Question: Express in one sentence what the figure is showing.
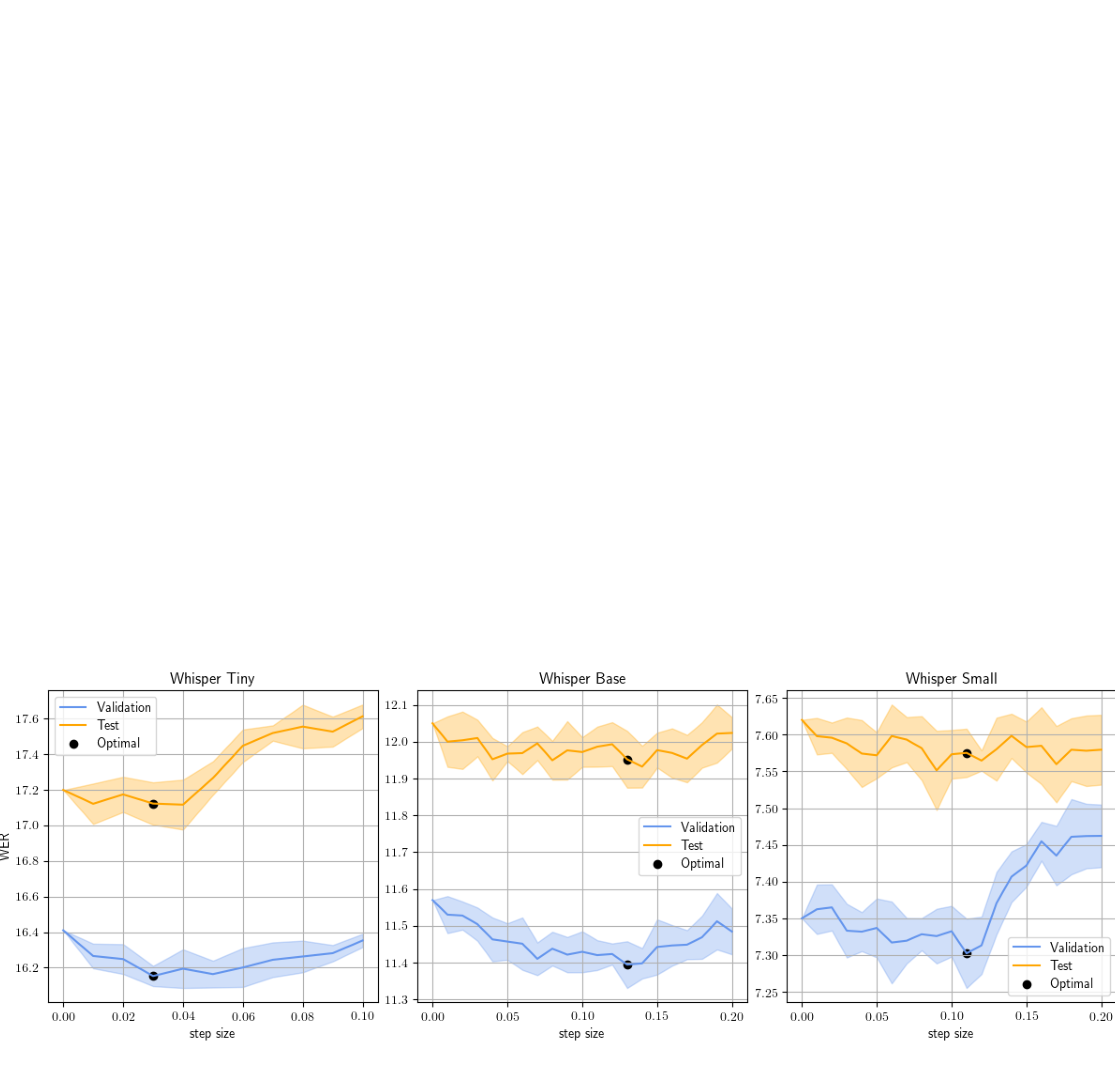
Answer: LibriSpeech other: Modifying encoder outputs using the gradient of a NAP. This shows how the performance changes when we vary the step size α of the modification. The optimal point was decided based on the minimum WER found on the validation set.